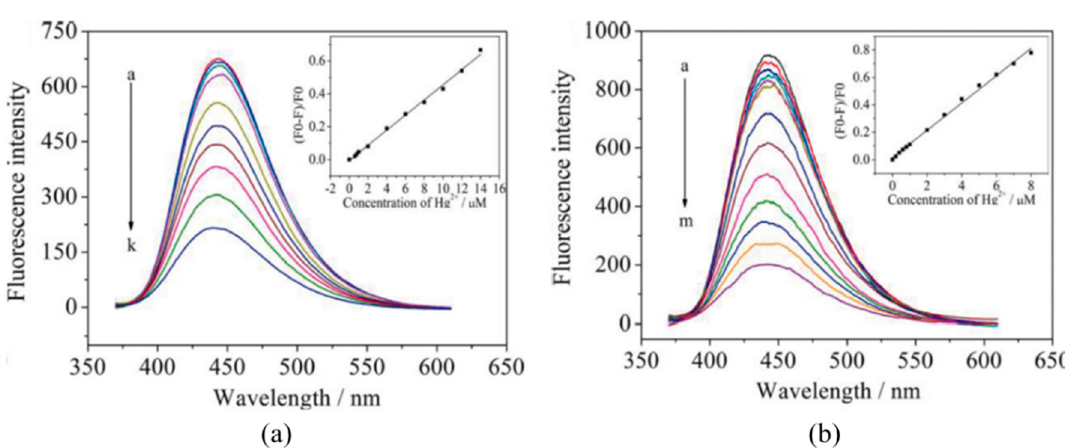
Figure 9. Fluorescence spectra of 10 μ g/mL carbon QDs ( a ) and N-carbon QDs ( b ) upon addition of different concentrations of Hg 2+ (a–k: 0, 0.6, 0.8, 1, 2, 4, 6, 8, 10, 12, and 14 μ M; a–m: 0, 0.2, 0.4, 0.6, 0.8, 1, 2, 3, 4, 5, 6, 7, and 8 μ M). The linear calibration ranges of each one of the sensors are shown in the insets. Reprinted with permission from [129].